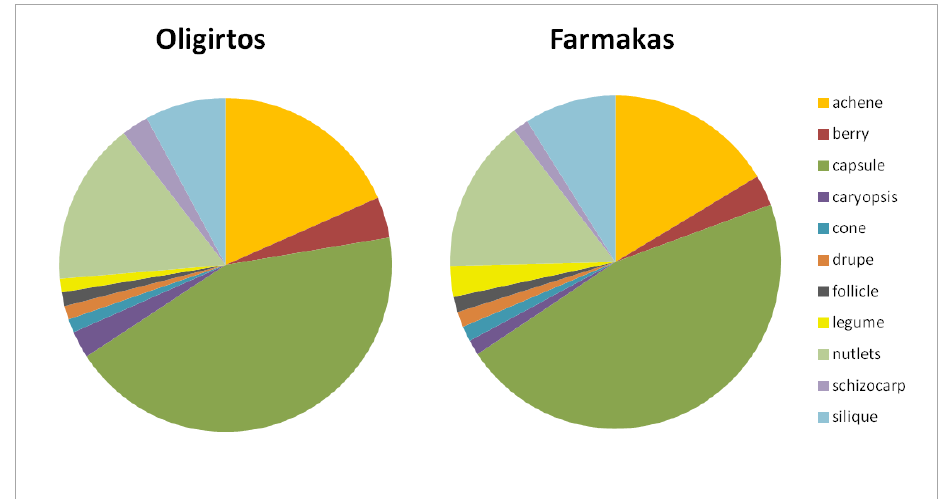
Figure 4. Fruit types of the Greek endemic taxa found in the flora of Mts. Oligirtos and Farmakas. (Kruskal – Wallis one-way ANOVA: H = 0.228, df = 1, p = 0.633).